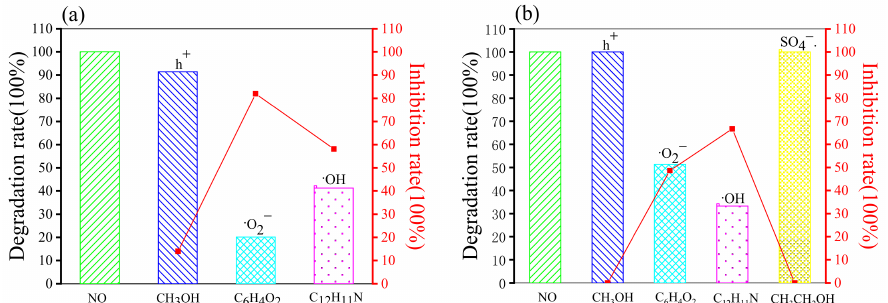
Figure 9. Photocatalytic degradation of MO in the synergistic systems with different quenching agents: ( a ) Quenching of MO degradation in the H 2 O 2 synergistic system; ( b ) Quenching of MO degradation in the Na 2 S 2 O 8 synergistic system.